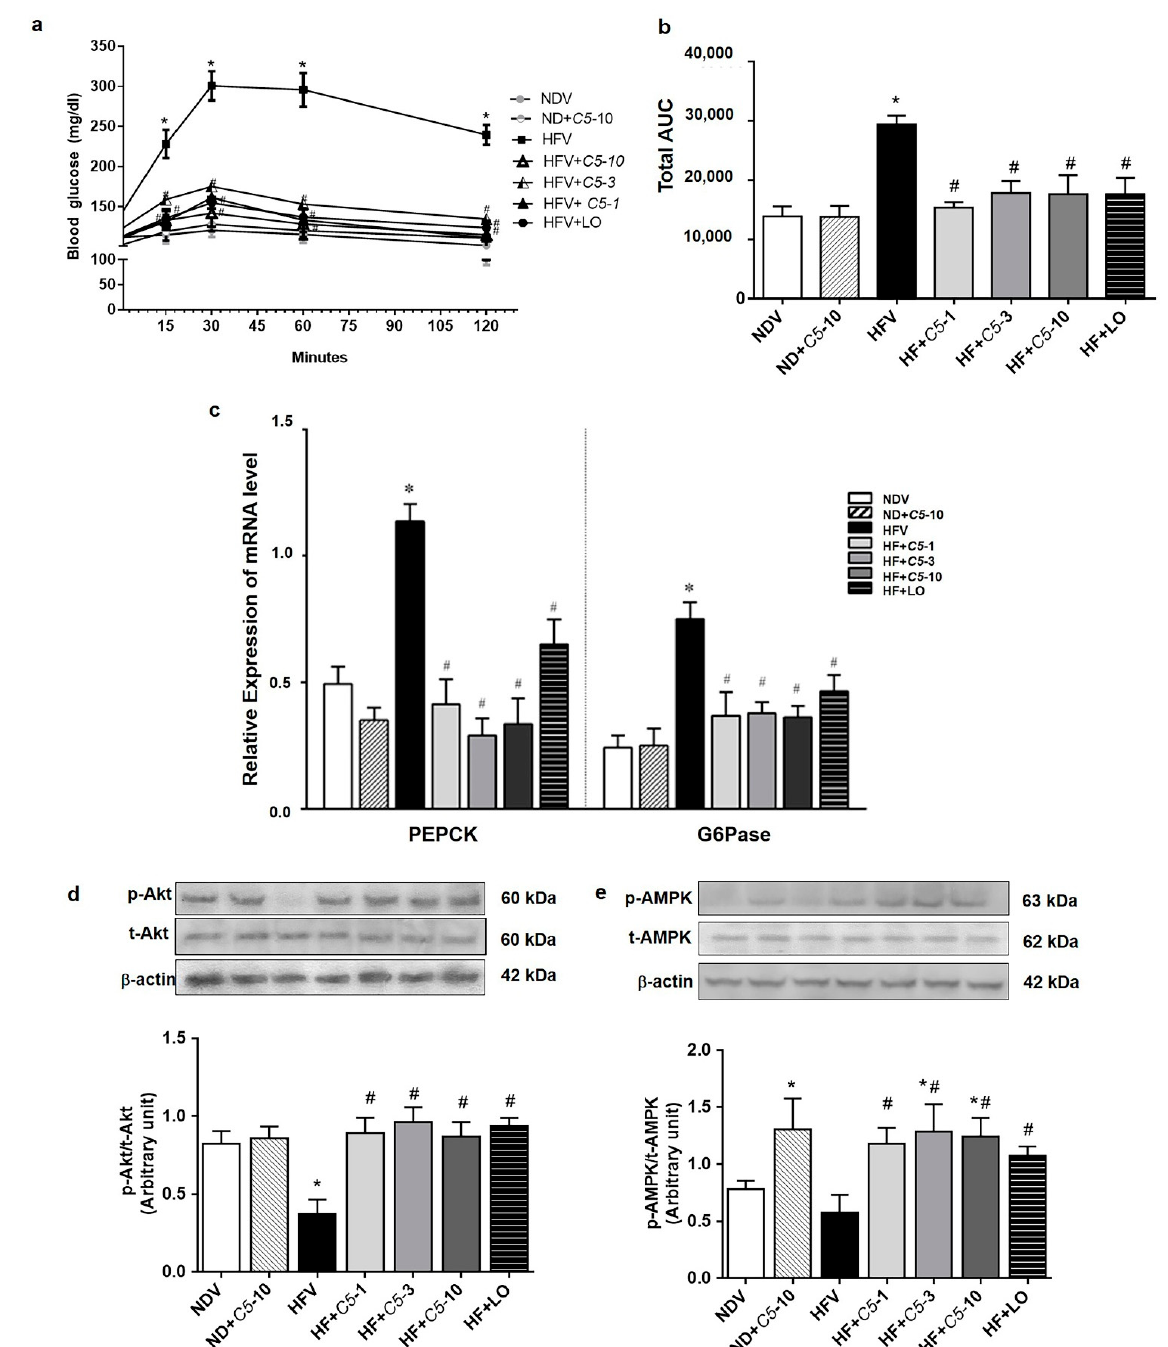
Commented [M2]: Replace the FIgrue 7 Please add a comma when number is up to “10,000”. For example,”40000” should written as “40,000”. Please revise the numbers in Figure 7. figure as requested.